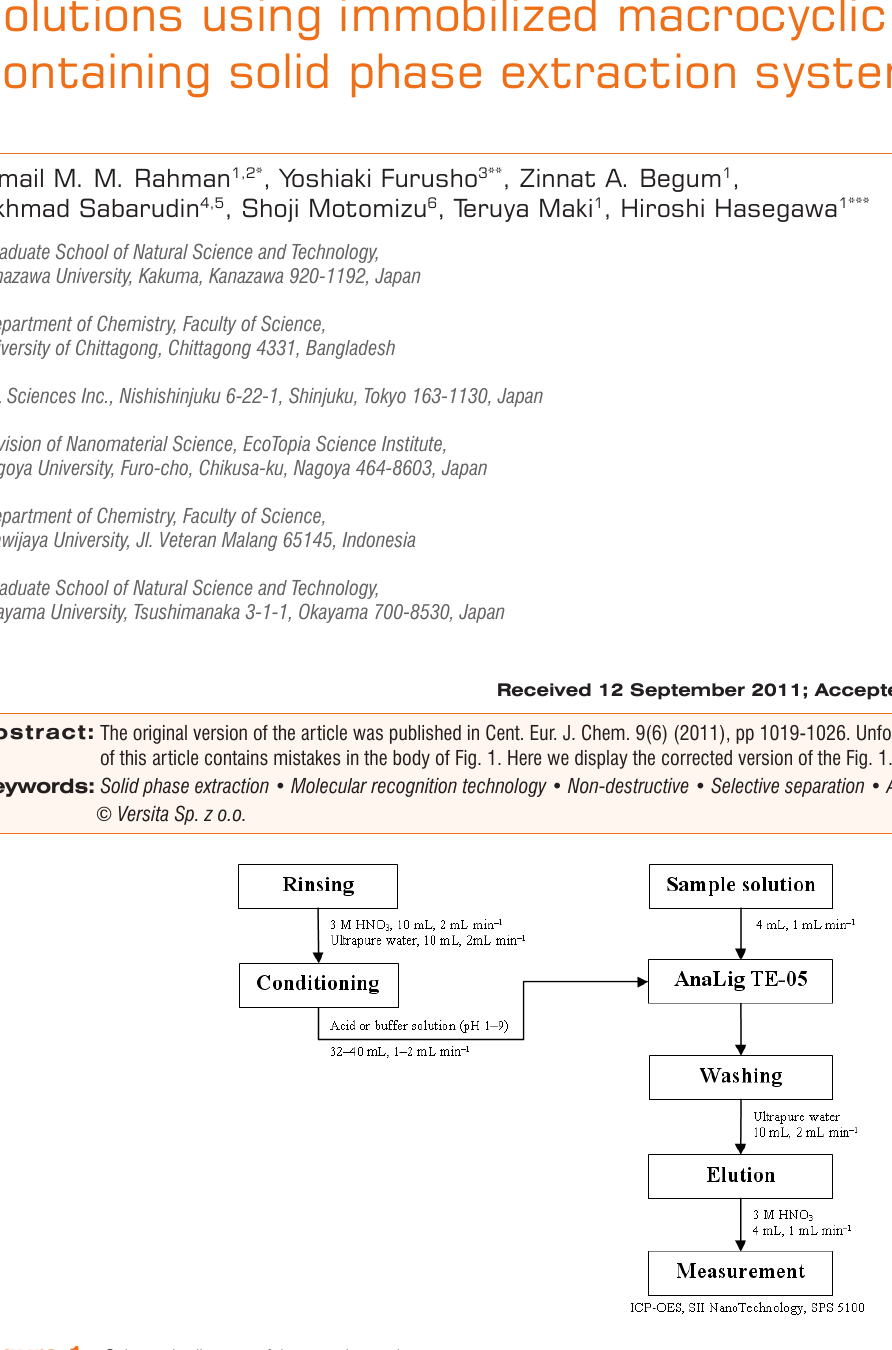
Figure 1. Schematic diagram of the experimental